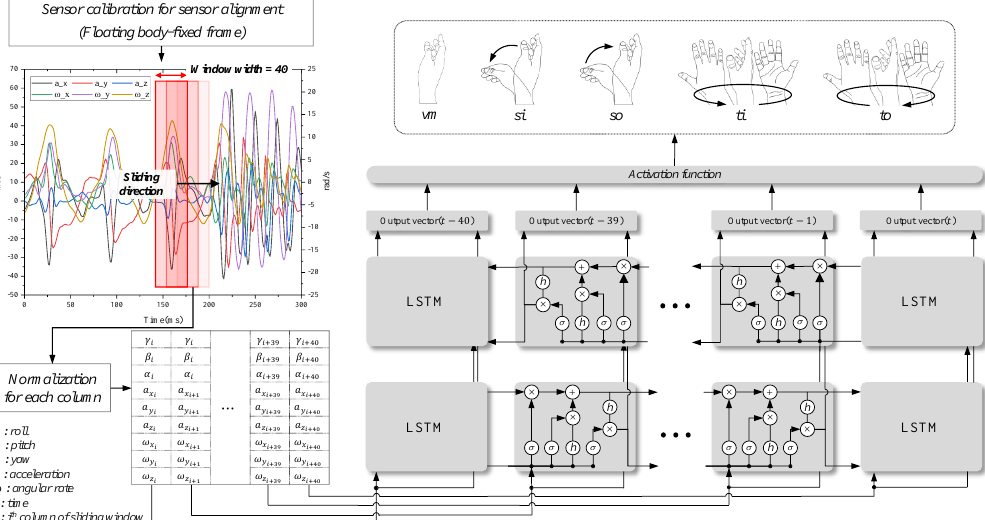
Figure 6. Overall framework of the bi-directional LSTM − based different hand-guiding gesture classification.